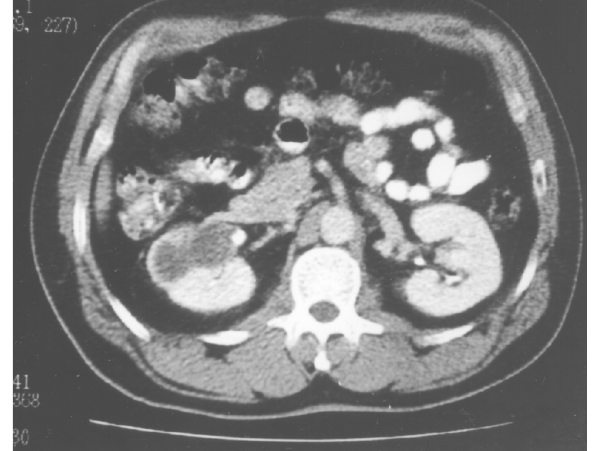
Figure 1 – Abdominal computerized tomography, showing hypodense image in right kidney, with inner calcification, sug- gestive of cystic